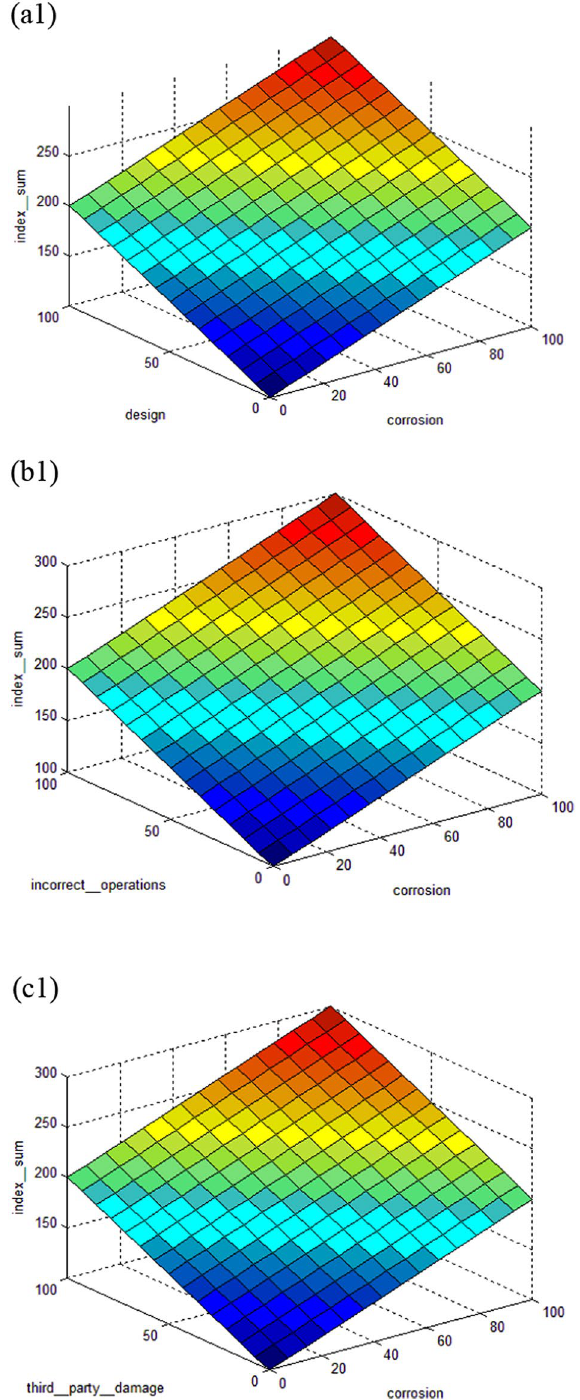
Figure 7. Control surface of index sum on ( a1 ) design and corrosion; ( b1 ) incorrect operations and corrosion; ( c1 ) third party damage and